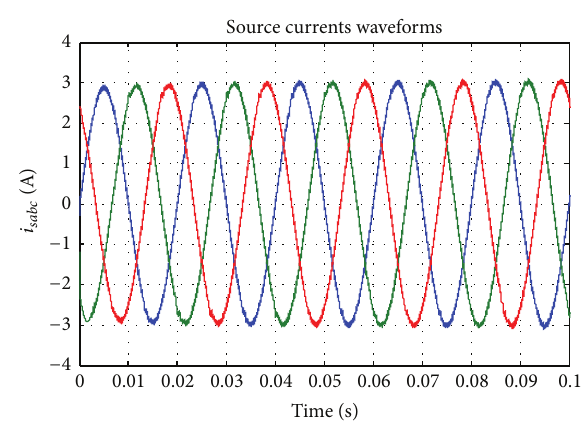
Figure 14: Source currents